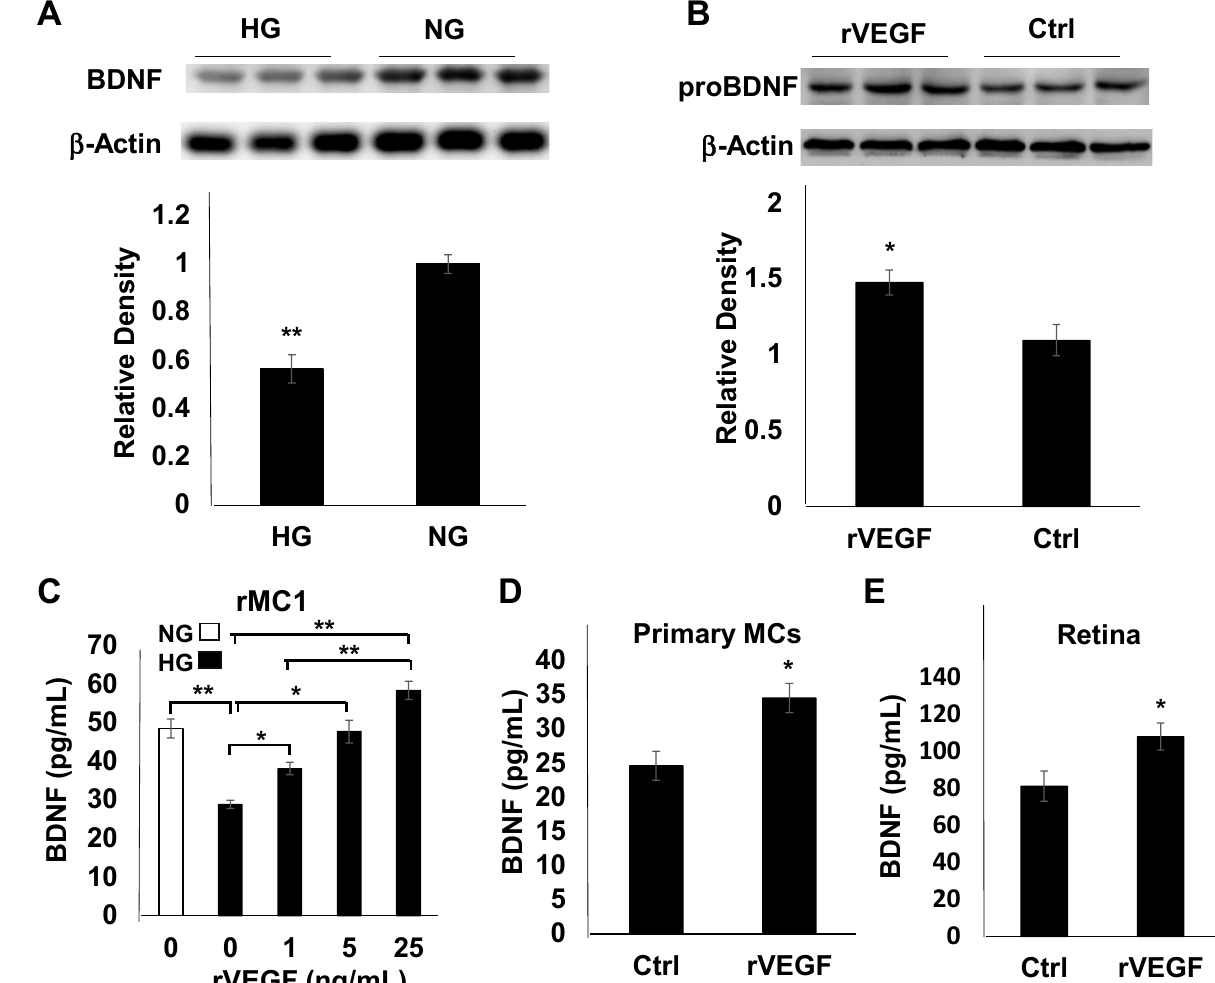
Figure 2. BDNF production in rMC1 cells and mouse primary MCs and retinas. ( A ) Immunoblotting analysis of BDNF synthesis using cell-free extracts from rMC1 cells cultured in NG and HG media for 48 h. ( B ) Immunoblotting analysis of rVEGF (20 ng/mL)-stimulated proBDNF synthesis using cell-free extracts from rMC1 cells cultured in NG media for 48 h. ( C ) ELISA analysis of VEGF-stimulated BDNF accumulation in culture supernatants of rMC1 cells grown in HG media for 48 h. ( D ) ELISA analysis of VEGF-stimulated BDNF accumulation in culture supernatants of primary MCs cells grown in HG media for 48 h. ( E ): ELISA analysis of retinal BDNF in 1 month old C57B6 background mice 1 day after intravitreal injection of rVEGF (0.2 µ g/eye). Graph bars represent mean ± SEM. *: p : 0.05; **: p < 0.01. VEGF upregulated BDNF production in MCs and mouse